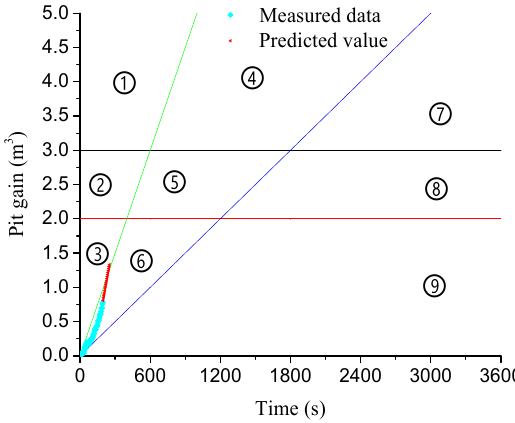
Figure 13. Kick severity analysis result using the forecasted pit gain.